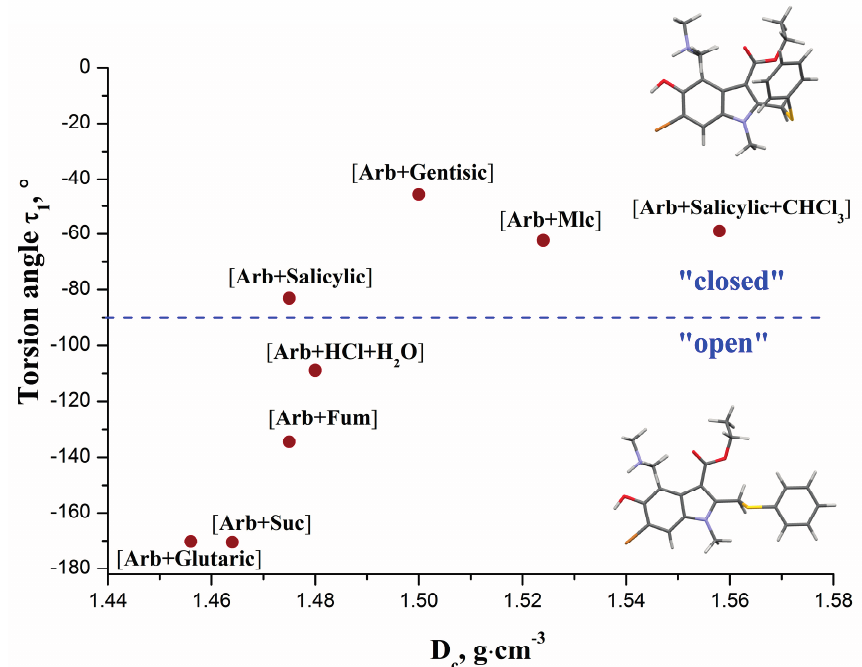
Figure 5. Value of the torsion angle  1 in the Arb molecule as a function of the calculated density of the corresponding